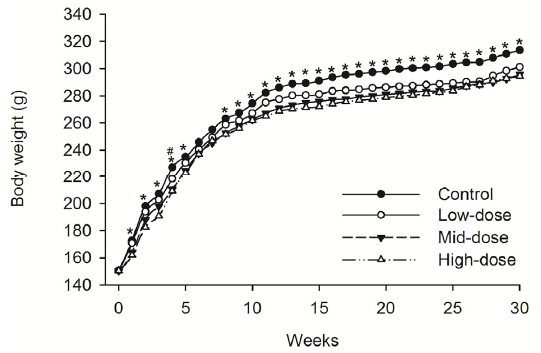
Figure 2. Mean body weight trend chart of female SD rats treated with STE. # p < 0.05 vs. Low-dose group. * p < 0.05 vs. Mid-dose group and High-dose group. Note: C = control group (distilled water), L = low-dose group (STE 3.75 mg/kg), M = mid-dose group (STE 7.50 mg/kg), H = high-dose group (STE 15.00 mg/kg). – x ˘ SD, d92 n = 5, d184 n = 10, d214 n = Table 3. Summary of hematology in male rats (